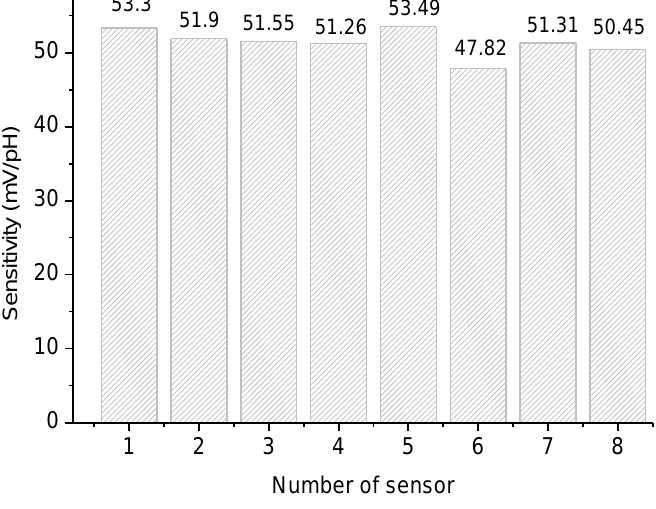
Figure 8. Sensitivity characteristics of ruthenium dioxide pH sensor array from pH 1 to pH 13 buffer